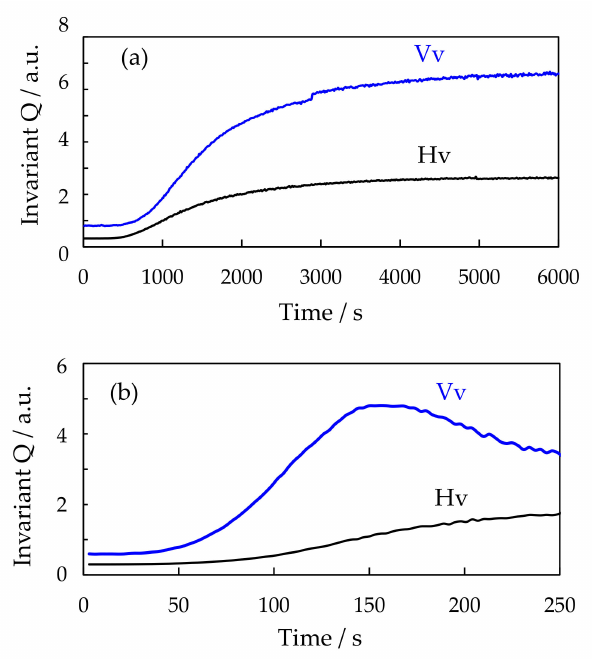
Figure 7. Time variation of invariant Q Hv and Q Vv for 60 / 40 PTT / PET during isothermal annealing at di ff erent temperatures: ( a ) 230 ◦ C, ( b ) 210 ◦